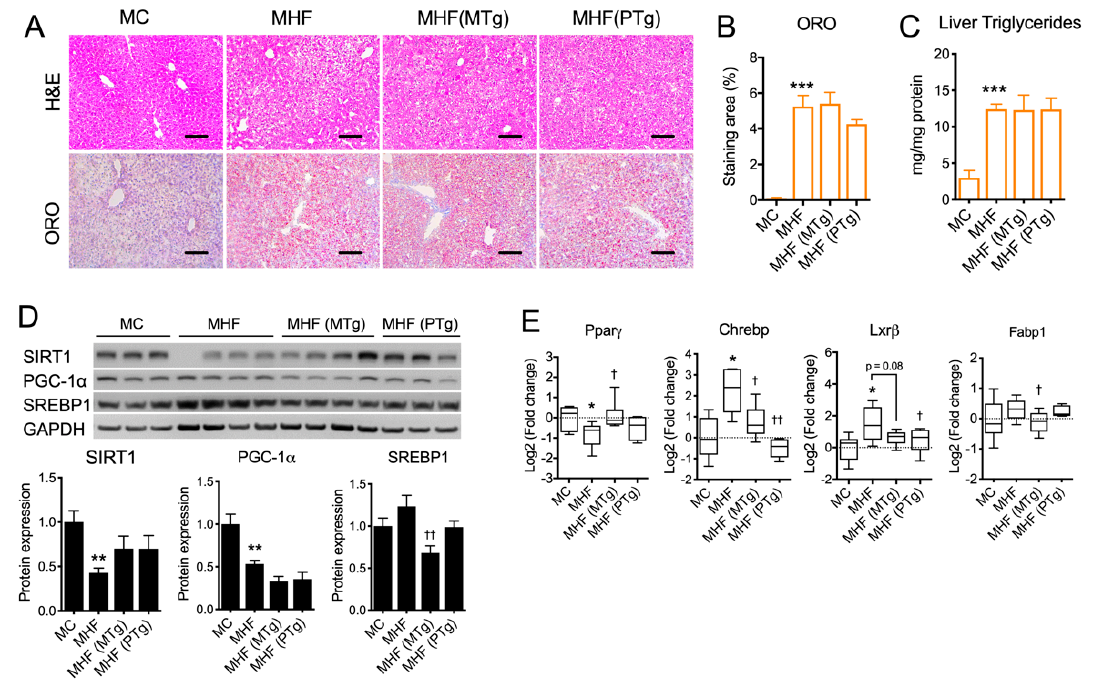
Figure 3. E ff ects of parental SIRT1 overexpression on hepatic morphology and the regulation of metabolic markers in MHF o ff springs’ livers ( A ) H&E and Oil Red O staining. Scale bar = 100 µ m. ( B ) Oil Red O staining quantitation. ( C ) Liver triglyceride level. ( D , E ) protein and mRNA expression of metabolic markers. n = 4–6. vs. MC: * p < 0.05, ** p < 0.01, *** p < 0.001; vs. MHF: † p < 0.05, †† p <